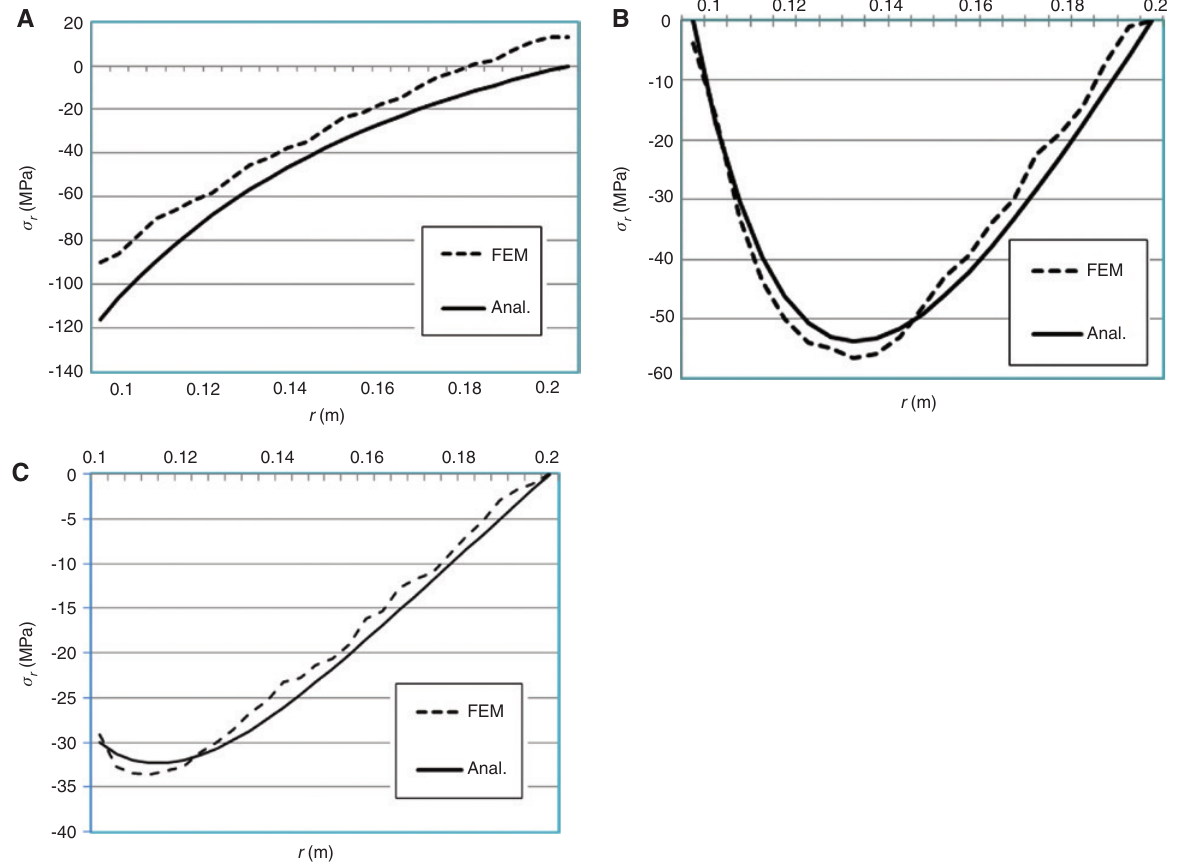
= 118 MPa, (B) temperature gradient Δ T = 290 ° K and (C) a